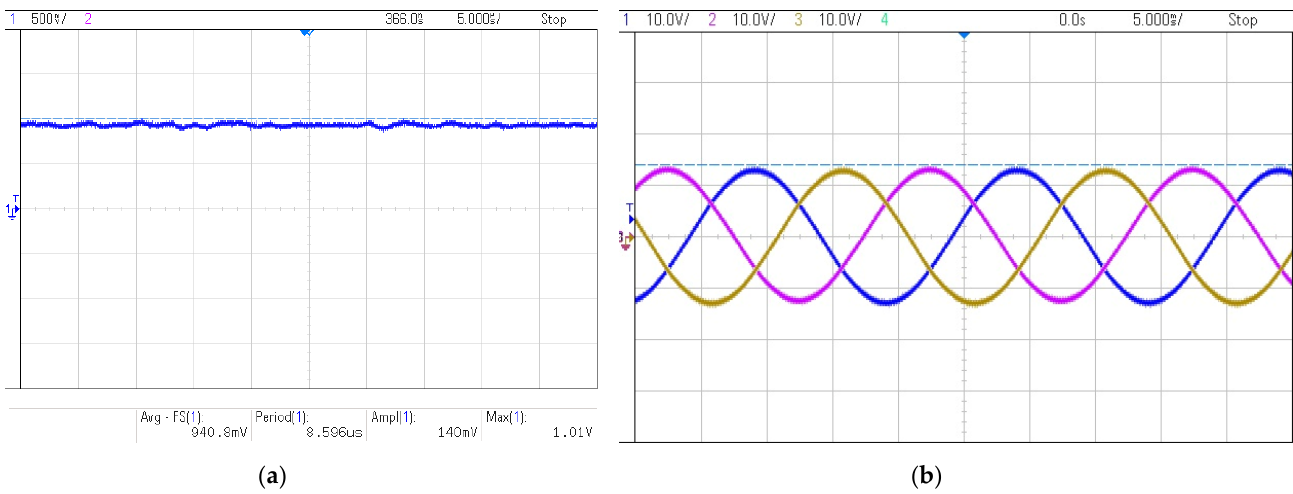
Figure 27. The experimental voltage waveforms of the FS-PDCC-based three-phase VSI: ( a ) The output of the voltage sensor IC ACPL-C870, ( b ) the experimental output voltage waveform of the predictive current-controlled three-phase VSI (Scale: Y-axis: 10 V/div; X-axis: 5 ms/div).